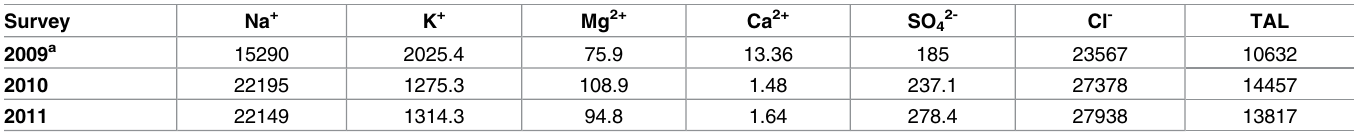
Table 1. Concentration of major